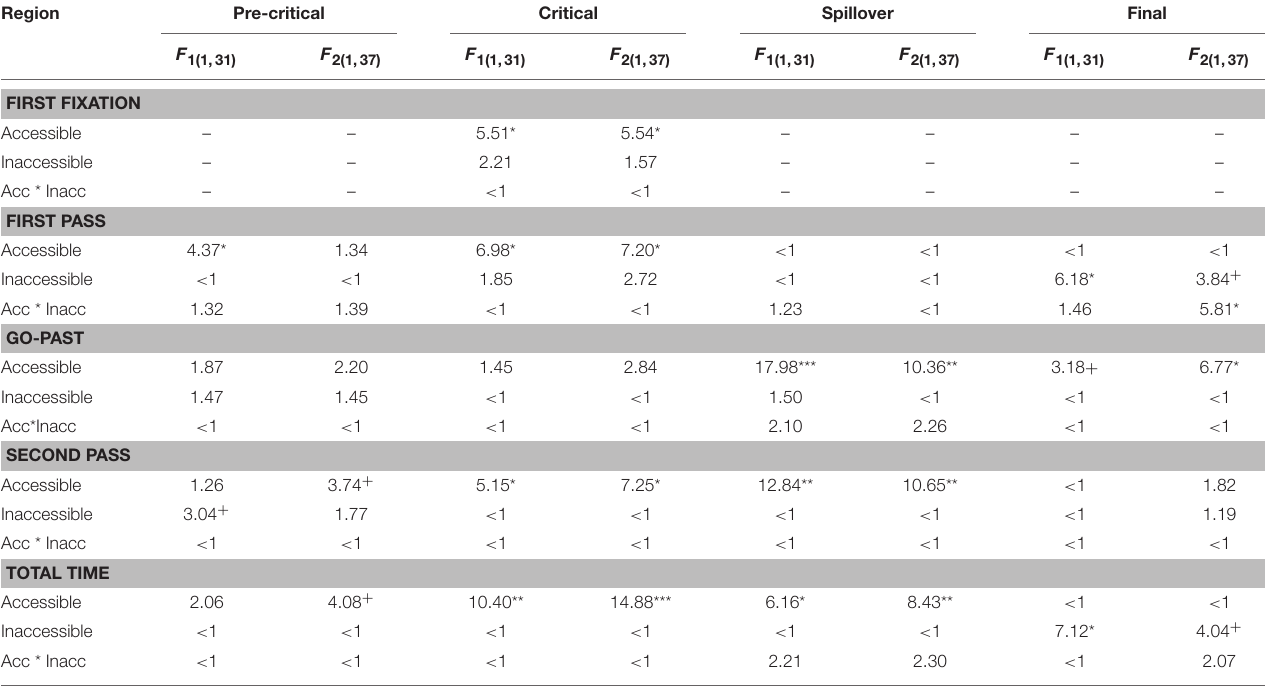
TABLE 2 | Anova results for Experiment 1 ( + p < 0 . 1 ; * p < 0 . 05 ; ** p < 0 . 01 ; *** p < 0 . 001 ).